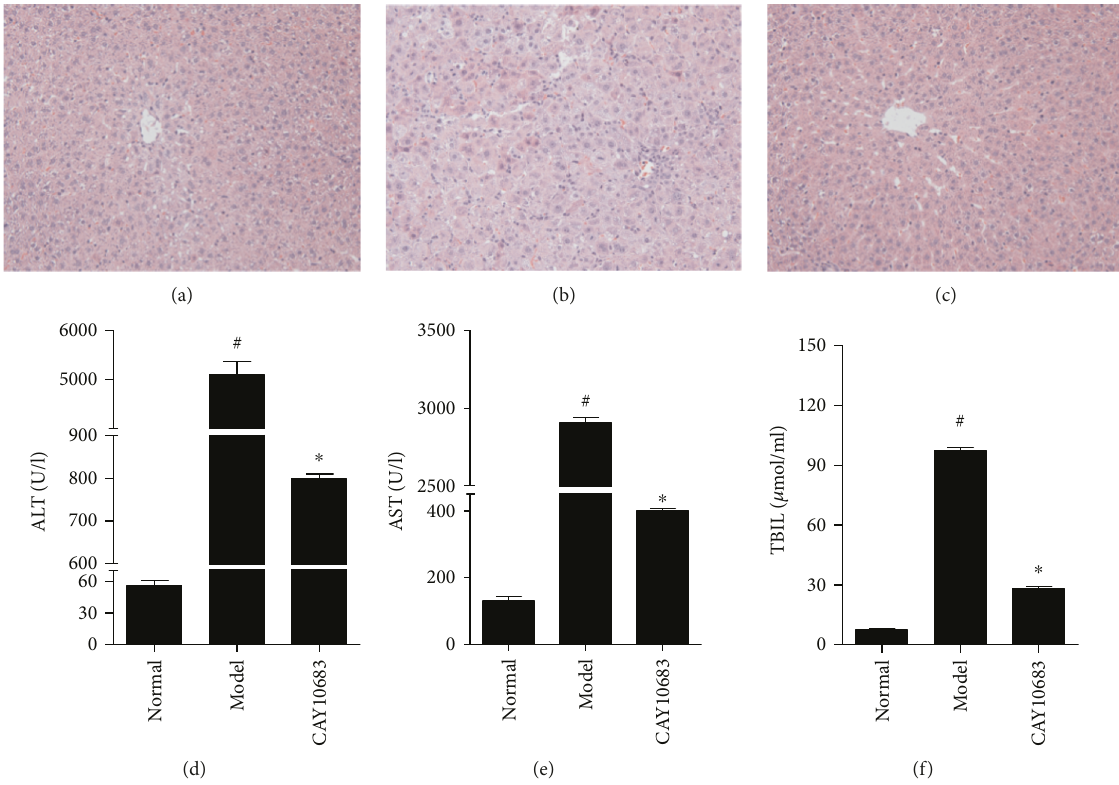
Figure 4: E ff ect of CAY10683 on hepatic pathological changes and serum biochemical indicators in ALF rats: (a) normal group, (b) model group, and (c) CAY10683 group. (d – f) E ff ect of CAY10683 on serum ALT, AST, and TBIL in ALF rats. Values are expressed as mean ± SD. # P < 0 05 , compared with normal group; ∗ P < 0 05 , compared with model